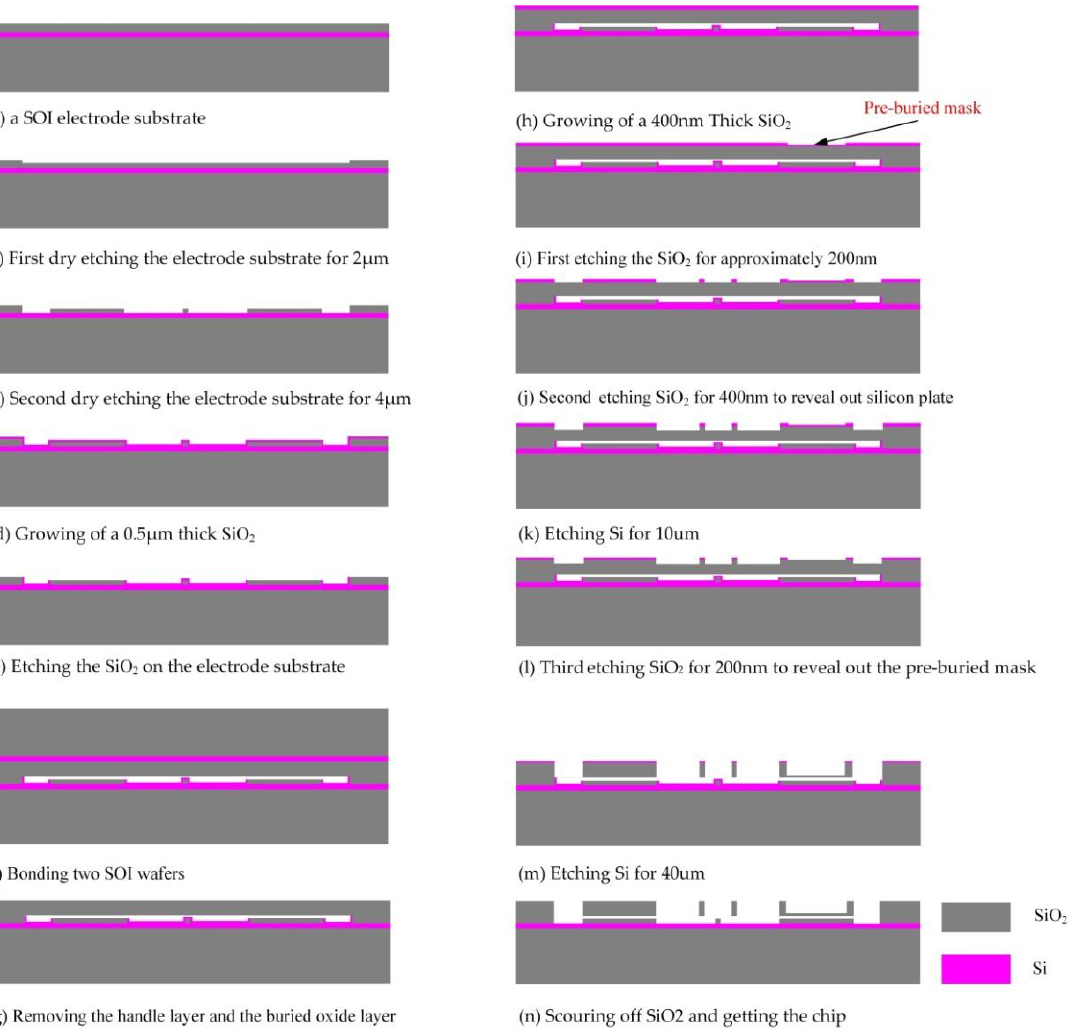
Figure 12. The fabrication process of the accelerometer.